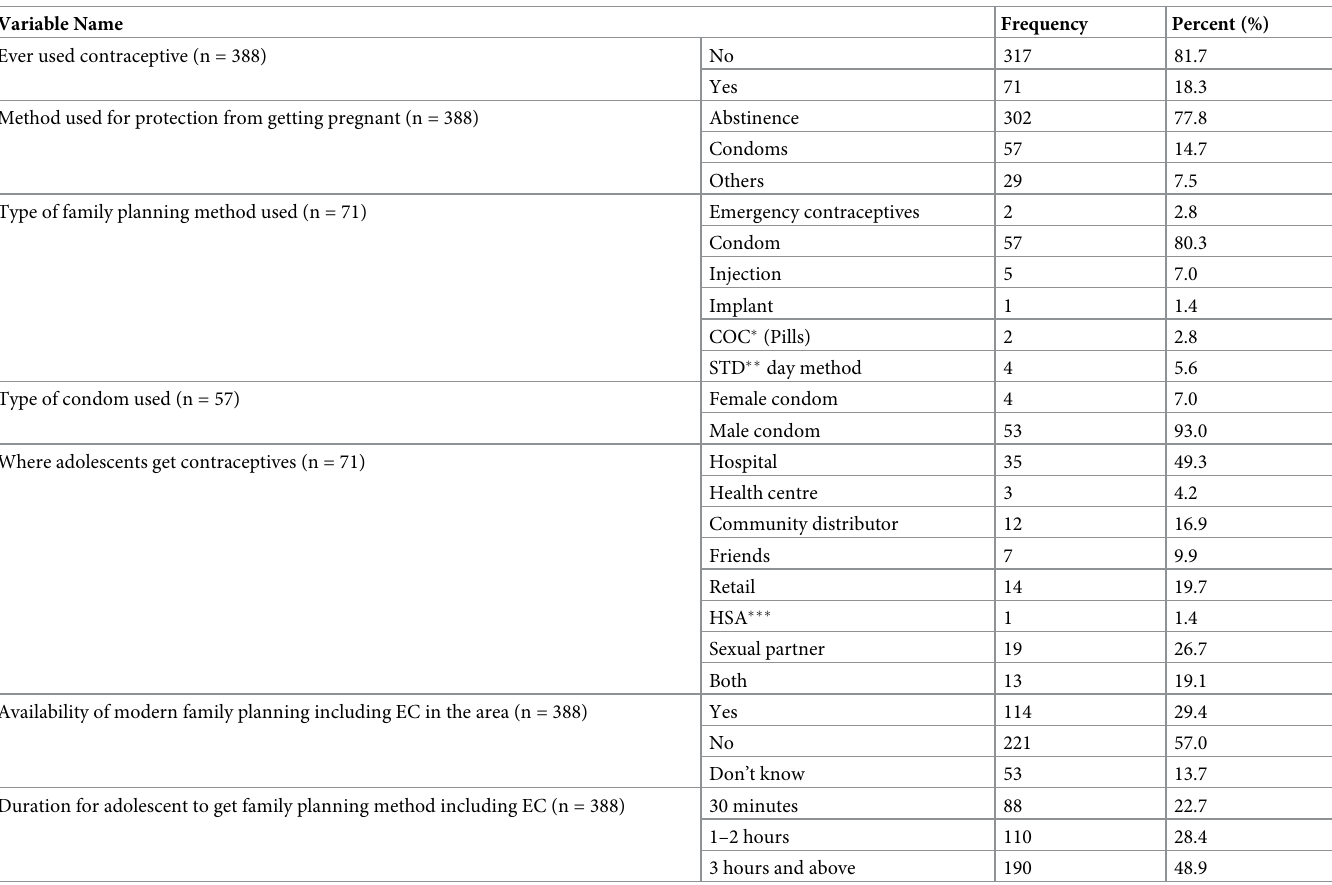
Table 2. Usage and availability of modern family planning services including ECs to school going adolescent girls in Phalombe